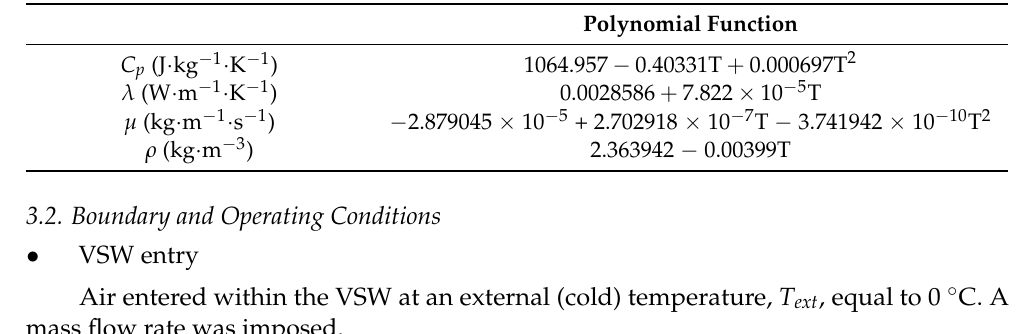
Table 5. Thermophysical properties of the air as a function of its temperature (K).